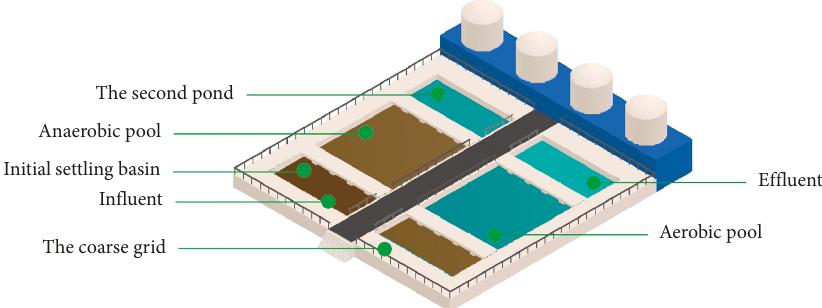
Figure 1: Sewage treatment process flow.